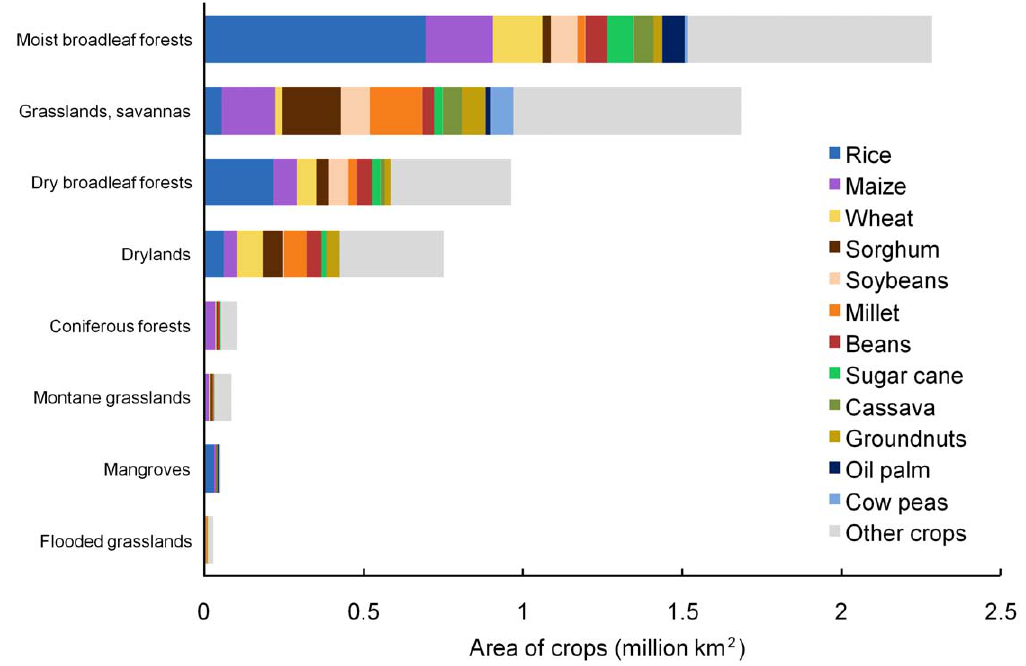
Figure 3. Area of different crops as a proportion of cropland in biomes within tropical countries. The top 12 tropical crops (see text) are identified. The width of each bar in this figure is equivalent to the width of the brown portions of the bars in Figure 2A. Source: [44].